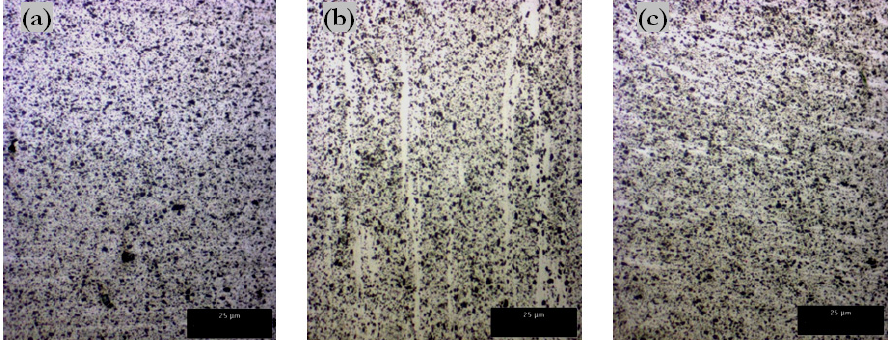
Figura 10: Distribuzione del rinforzo particellare nel composito AMC225xe saldato mediante LFW: (a) centro del cordone di saldatura, (b) materiale base, (c) TMAZ.